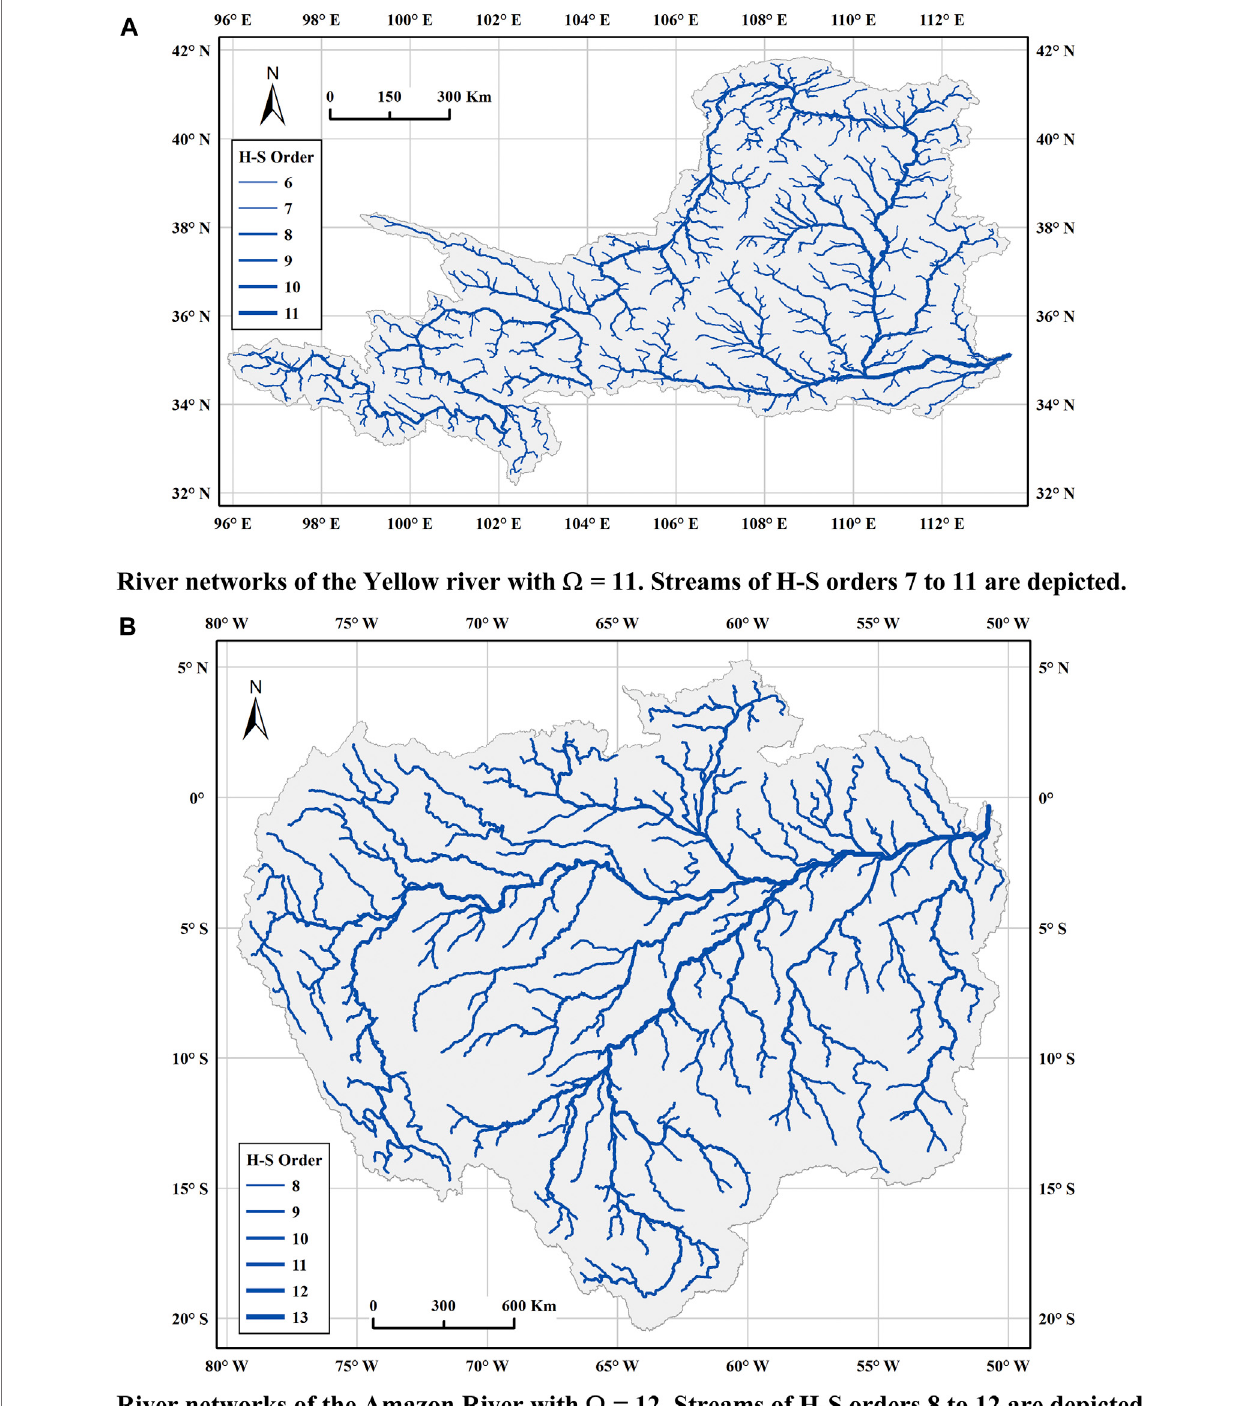
FIGURE 10 | River networks of the Yellow River and the Amazon River with streams of no less than an H-S order 7 are shown in the fi gure.